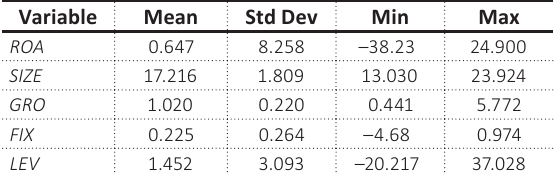
Table 3. Summary statistics